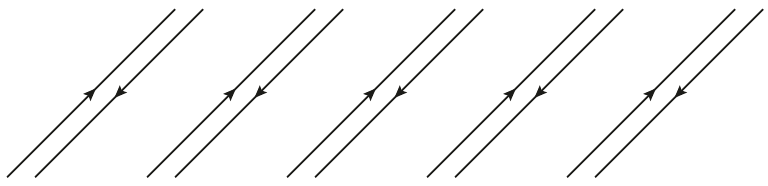
Figure 1 . Physical setup of wires system. The arrows represent electrons propagating in both right and left ways.